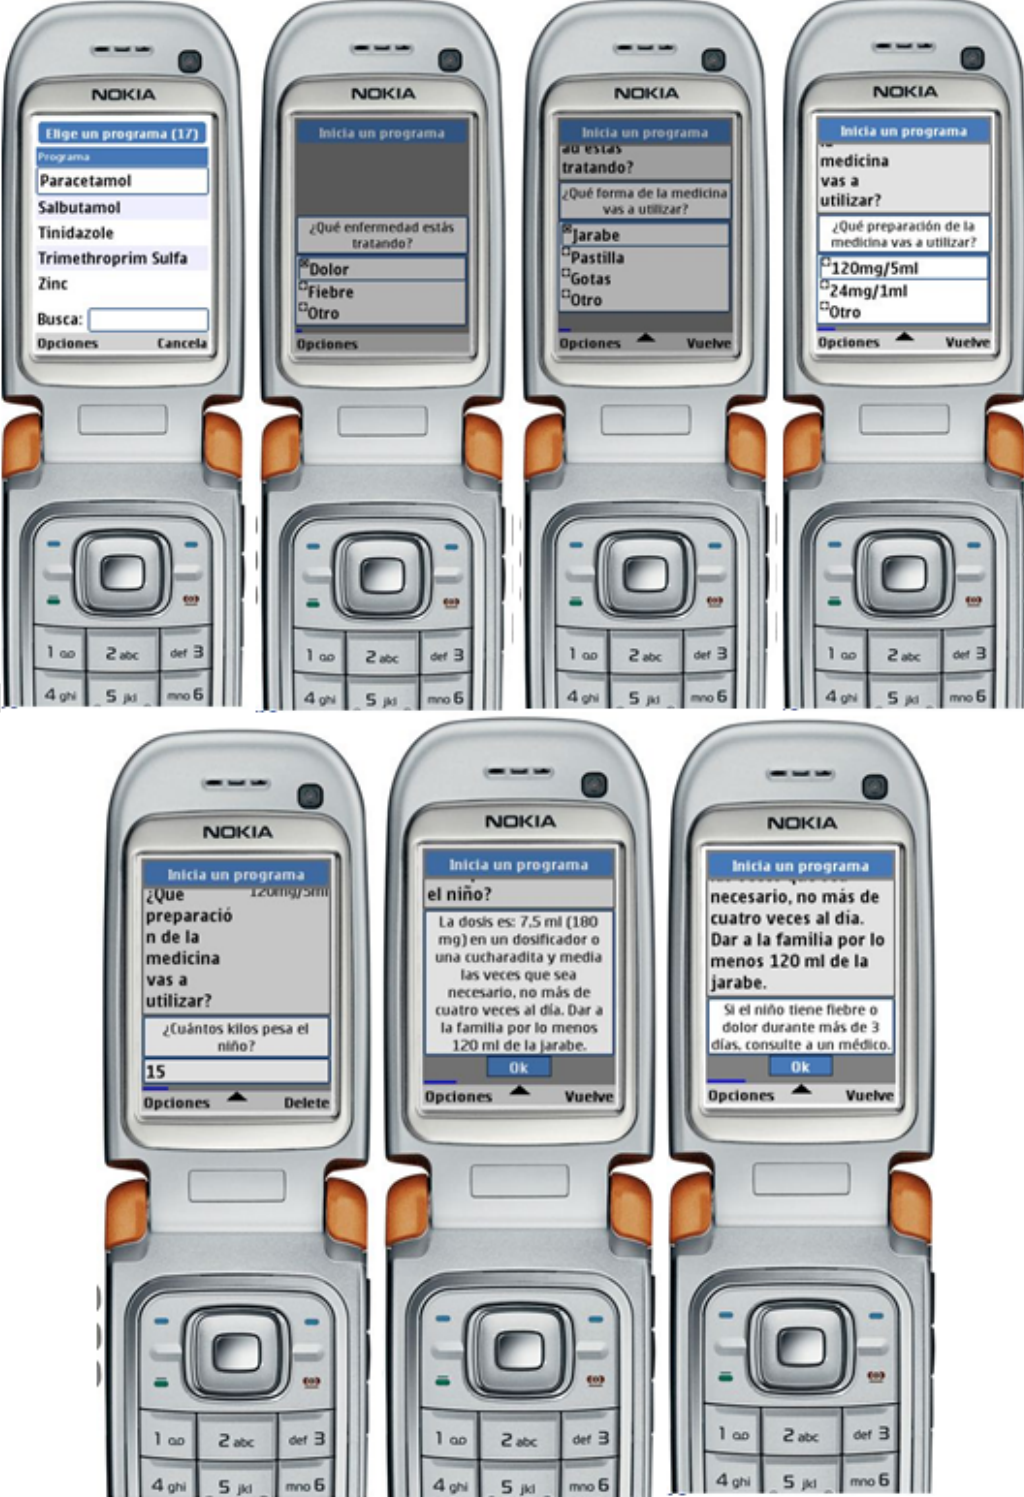
Figure 1. Screenshots of mHealth tool “chatter box” running through the Paracetamol algorithm for a